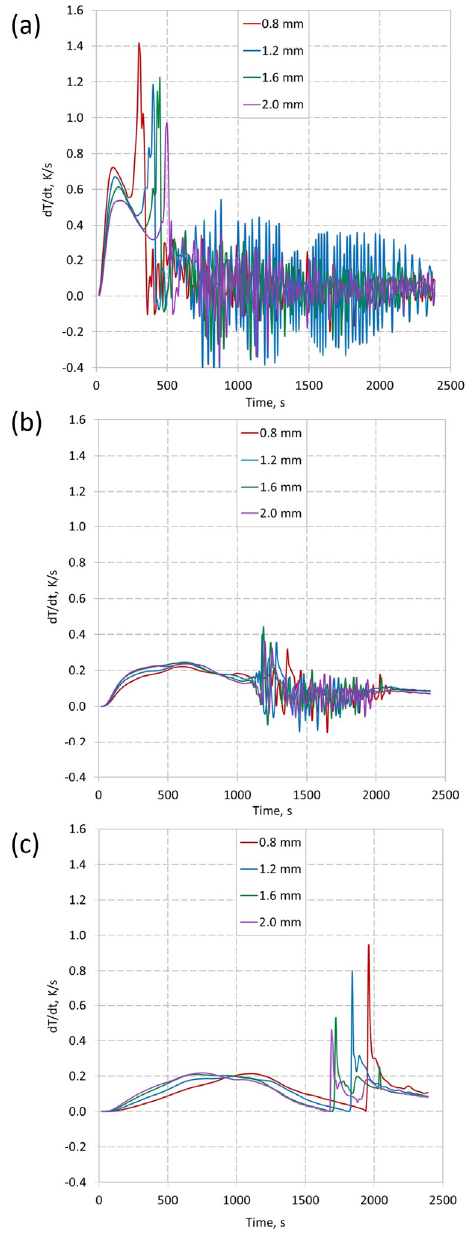
Figure 10. Derivation evolution on three different heights, for four thicknesses of the insert: ( a ) h = 12 mm; ( b ) h = 50 mm; ( c ) h = 87 mm.